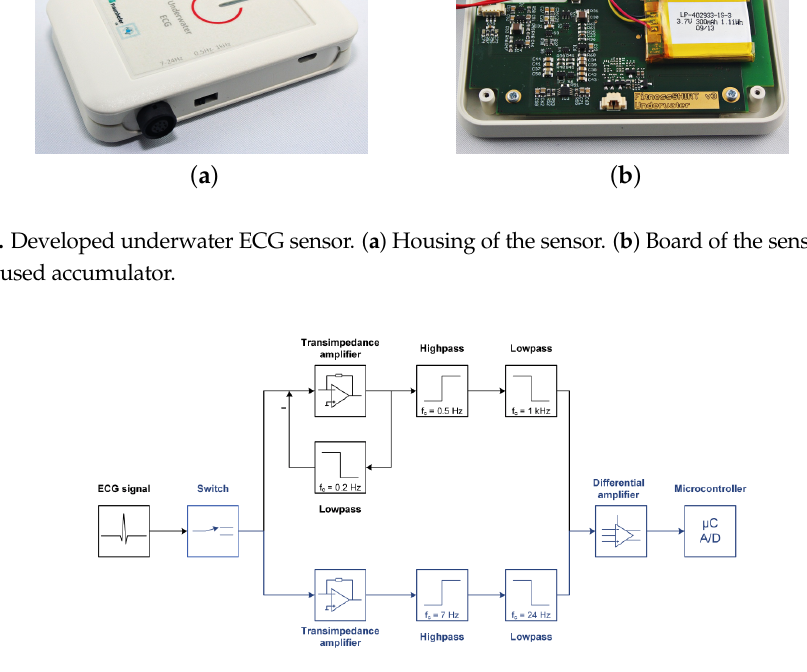
Figure 2. Block diagram of the developed circuit for current-based measurements of the cardiac